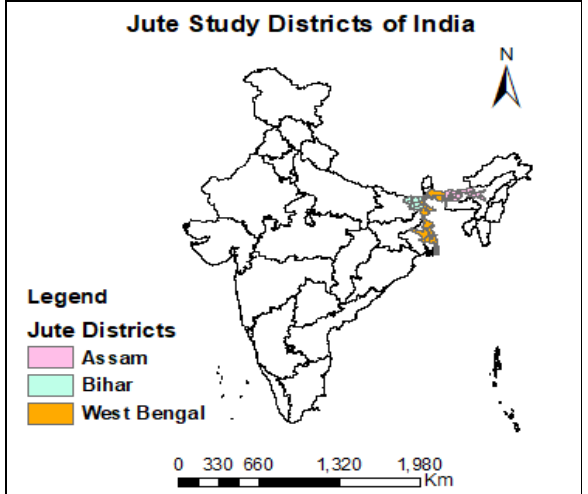
Figure1. Jute study districts of India under FASAL Project